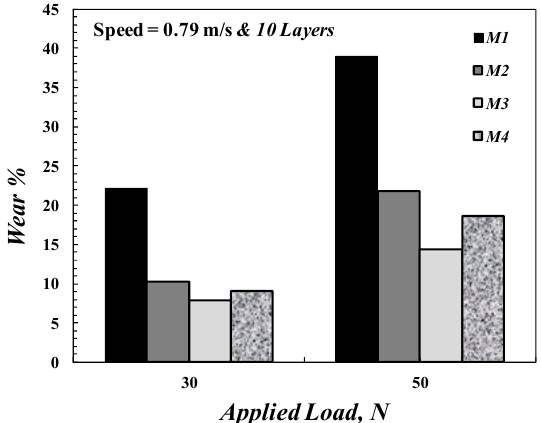
Figure 8. Wear rate as a function of average glass fiber volume of fraction, V fa .